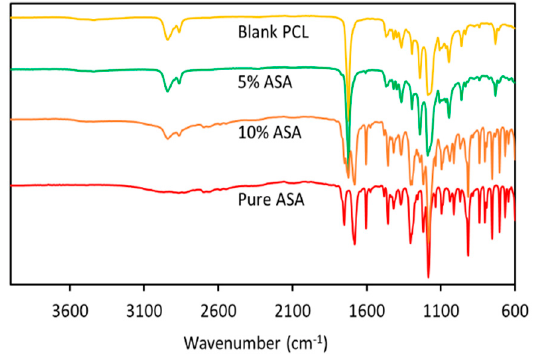
Figure 3. FTIR spectra of ASA and 3D printing tubular grafts containing different ASA content.